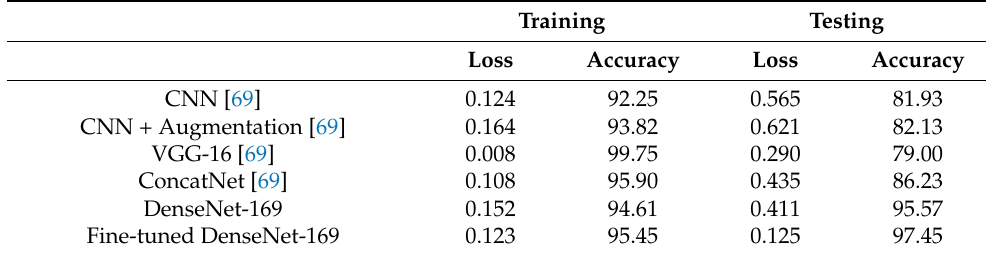
Figure 11. Loss associated with batches processed after fine-tuning the model. Table 4. The hyperparameter values are associated with various